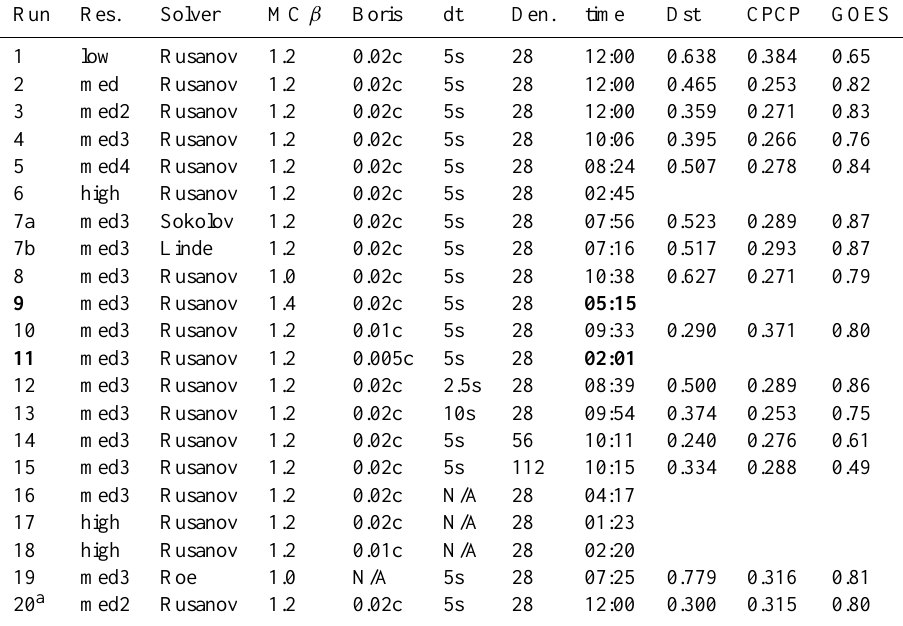
Table 1. A description of the 21 different simulations that were conducted for this section of the study. The column “time” shows the final simulation time corresponding to 8h of execution. The nRMS errors only include the first seven hours of the simulation (indicated by the vertical lines in Figs. 14–16, to make sure that most of the simulations can be compared equally. The bold-faced simulation numbers are runs that crashed because of negative pressures (typically in the lobes). Further details are described within the